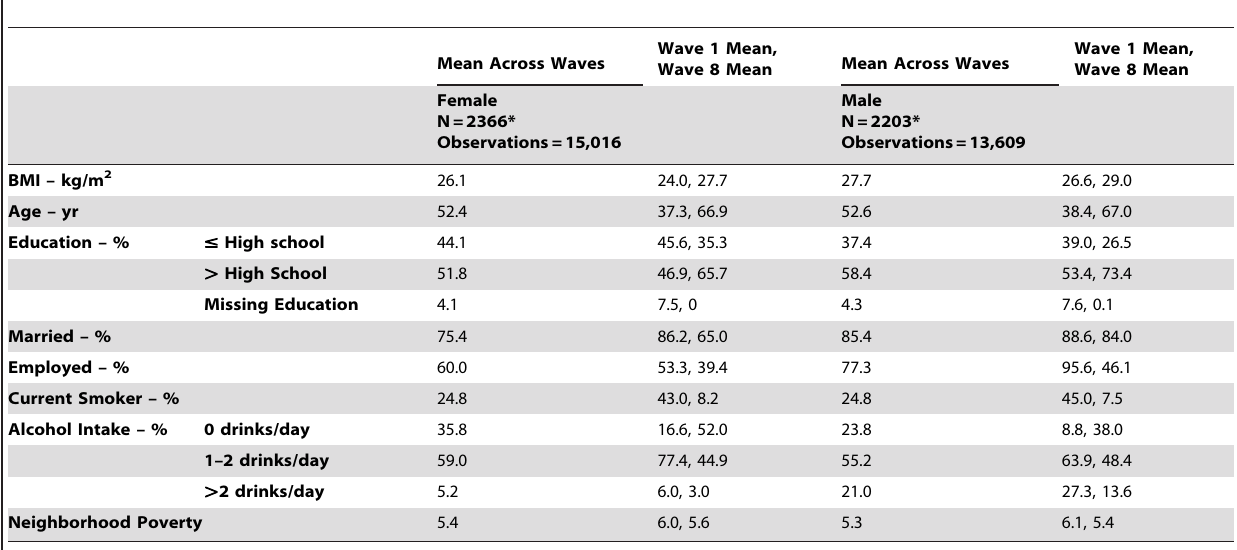
Table 1. Characteristics of Sample, Framingham Heart Study Offspring Cohort, 1971 to